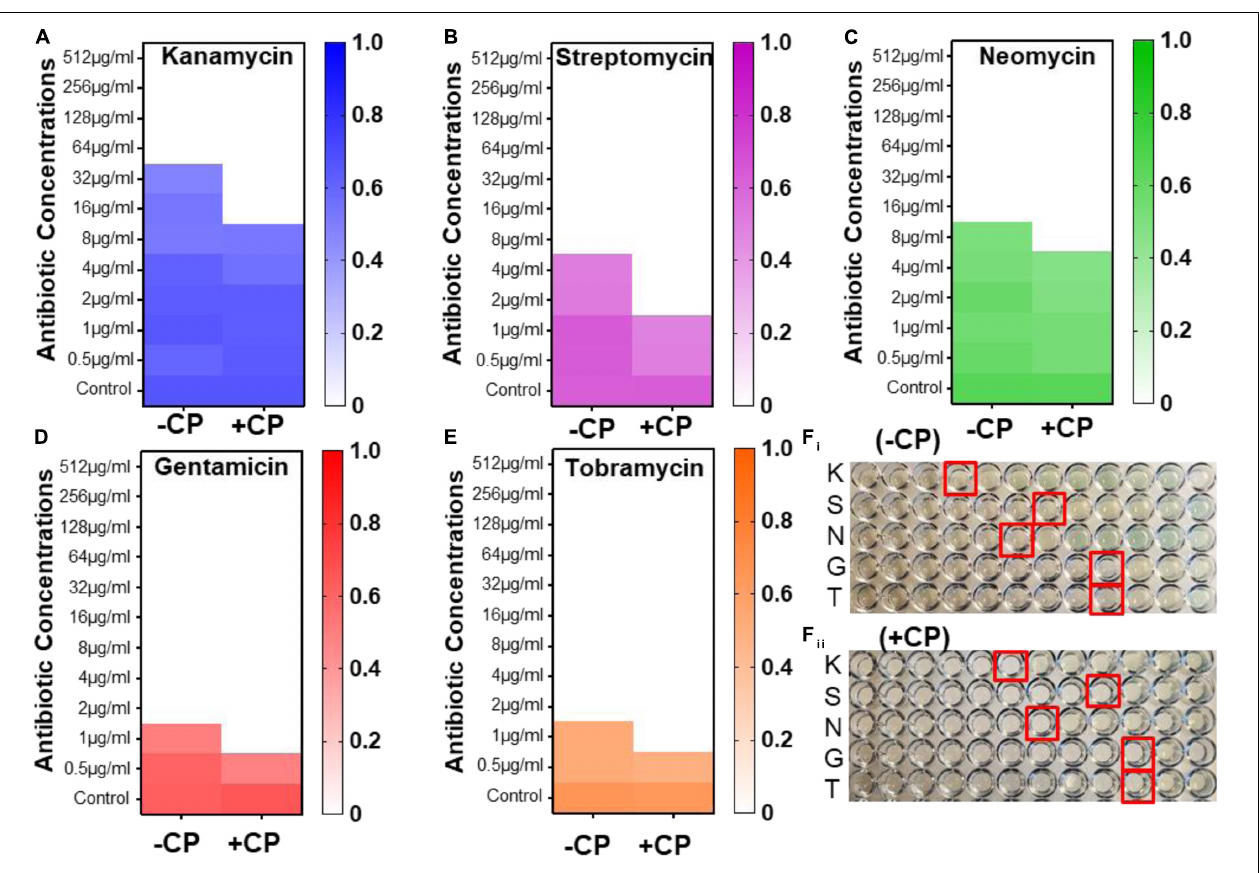
FIGURE 6 | Synergistic antimicrobial effects of CP and aminoglycosides against Pseudomonas aeruginosa PAO1. Heat map of OD 600 nm of P. aeruginosa PAO1 with kanamycin (A) , streptomycin (B) , Neomycin (C) , Gentamicin (D) , and Tobramycin (E) in presence and absence of CP. Image of microtiter plate showing the MIC of aminoglycosides against P. aeruginosa PAO1 in the 96-microtiter plate with and without CP (F i ,F ii ) . (Red rectangular boxes in the image represents the MIC of aminoglycosides against PAO1-wells with no visible bacterial growth); K, kanamycin; S, streptomycin; N, Neomycin; G, Gentamicin; and T,